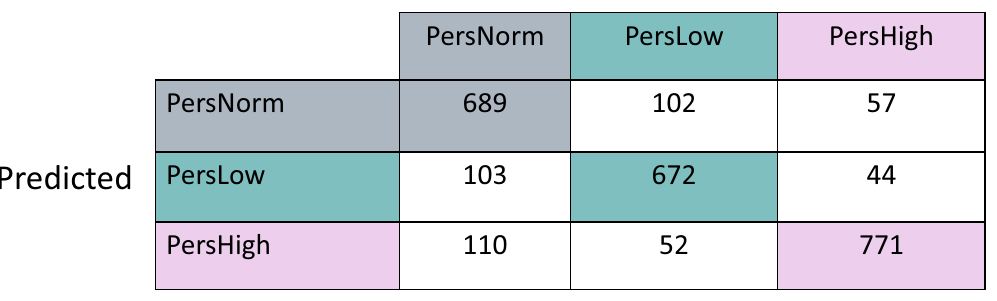
Fig. 4 Confusion matrix: multiclass model. Confusion Matrix for multiclass decision tree model validated with a 70/30 train/test split. In this model, the class-accuracy for PersHigh glucose is 82.6%, the class accuracy for PersNorm is 81.3%, and the class accuracy of PersLow is